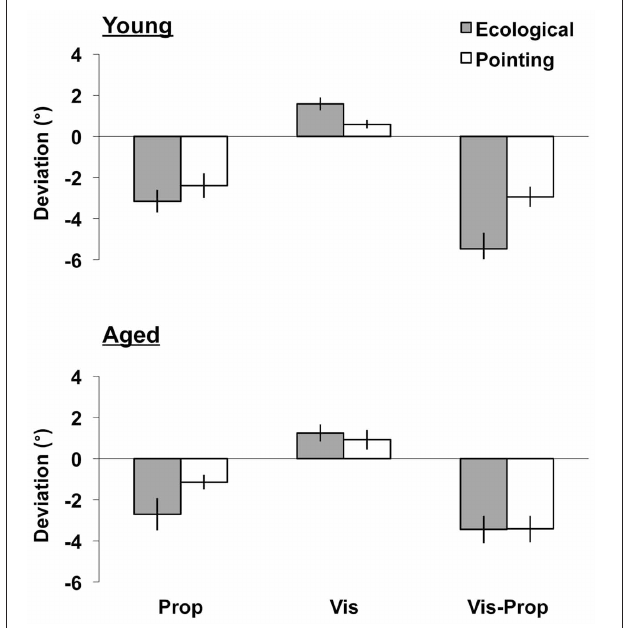
FIGURE 1 | Aftereffects. Upper/lower panels: young/aged groups. Shifts (post-prism exposure minus pre-prism exposure mean pointing errors ◦ , SEM ; ± : rightward/leftward errors) induced by prism adaptation in the three aftereffects tests (proprioceptive, Prop: left bars; visual, Vis: middle bars; visual-proprioceptive, Vis-Prop: right bars), during the ecological (gray column) and the pointing (white column) adaptation